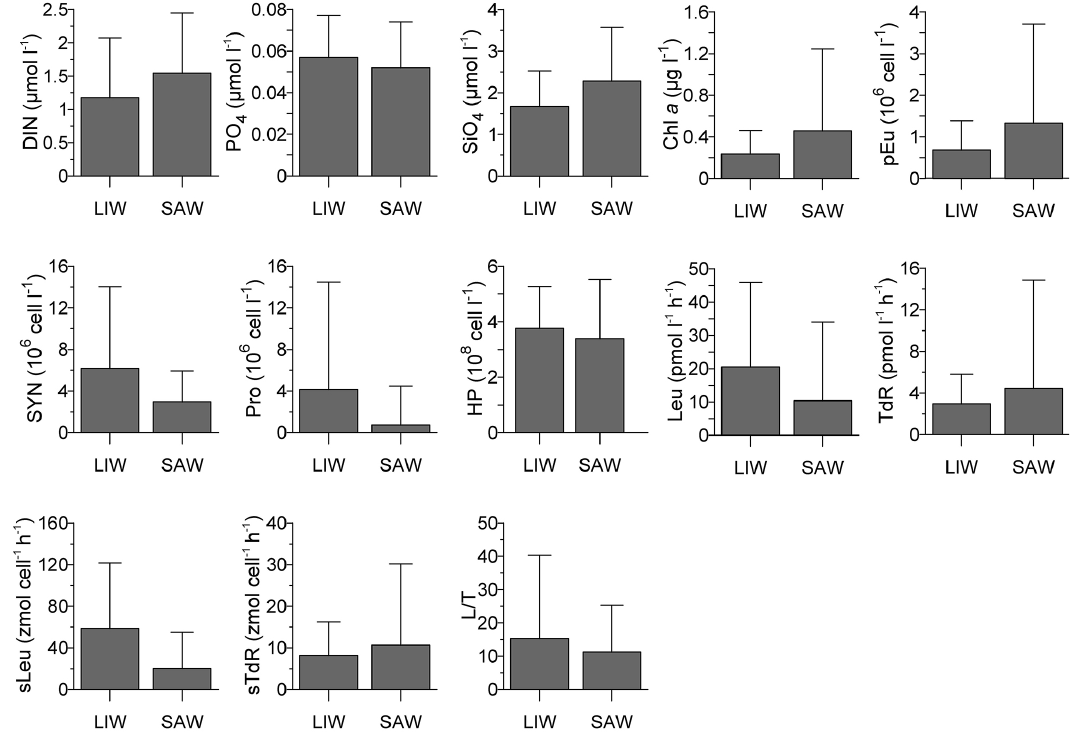
Figure 5. Dissolved inorganic nitrogen (DIN), phosphate (PO 4 ), silicate (SiO 4 ), chlorophyll a (Chl a ), abundances of picoeukaryotes (pEu), Synechococcus (SYN), Prochlorococcus (Pro), heterotrophic prokaryotes (HP), bulk and cell-specific prokaryotic heterotrophic rates for leucine (Leu, sLeu) and thymidine (TdR, sTdR) incorporation and their ratios (L/T) in Levantine intermediate water (LIW) affected and non-affected waters, Southern Adriatic waters (SAW) in the productive layer.